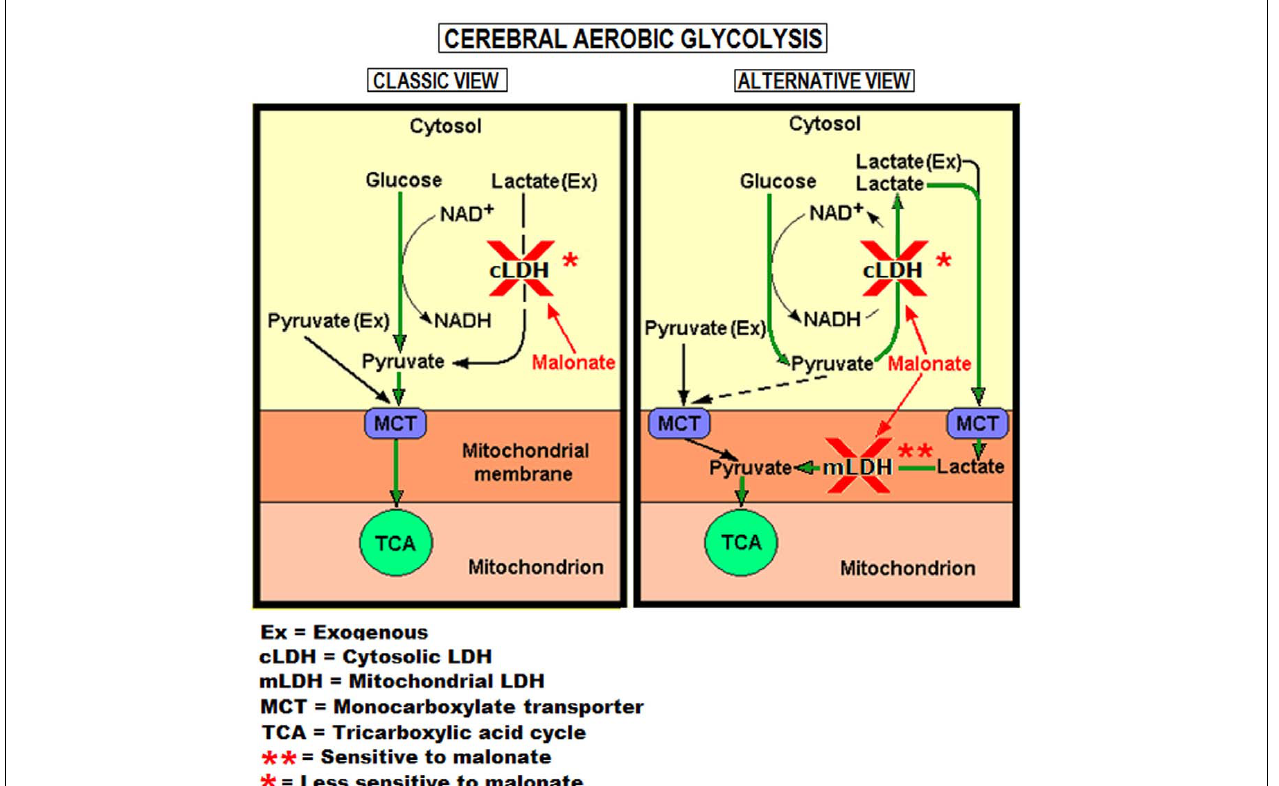
FIGURE 7 |Two views of aerobic glycolysis. The classic view depicts pyruvate as the glycolytic pathway’s end-product (green arrows, left